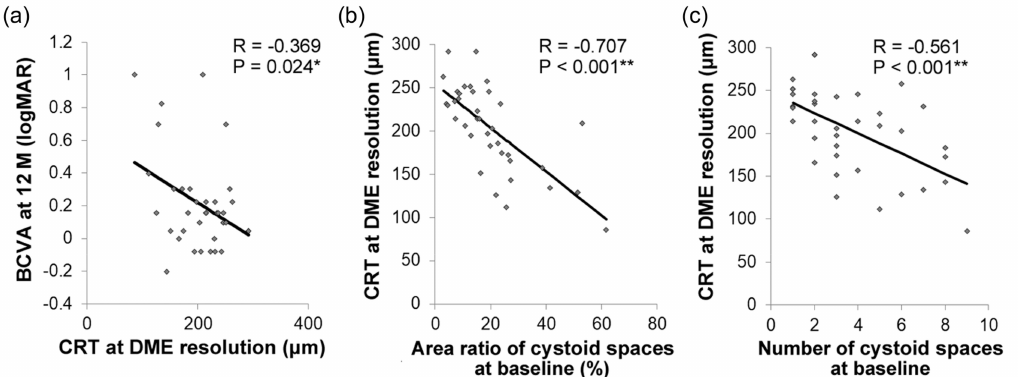
Figure 5. Association of the area ratio and number of intraretinal cystoid spaces at baseline with central retinal thickness (CRT) at the time of diabetic macular edema (DME) resolution. Pearson correlation coe ffi cient. ( a ) Central retinal thickness (CRT) at the time of DME resolution was negatively correlated with best-corrected visual acuity (BCVA) at 12 months. The area ratio ( b ) and number ( c ) of intraretinal cystoid spaces at baseline were negatively correlated with CRT at the time of DME resolution. ** p < 0.01.